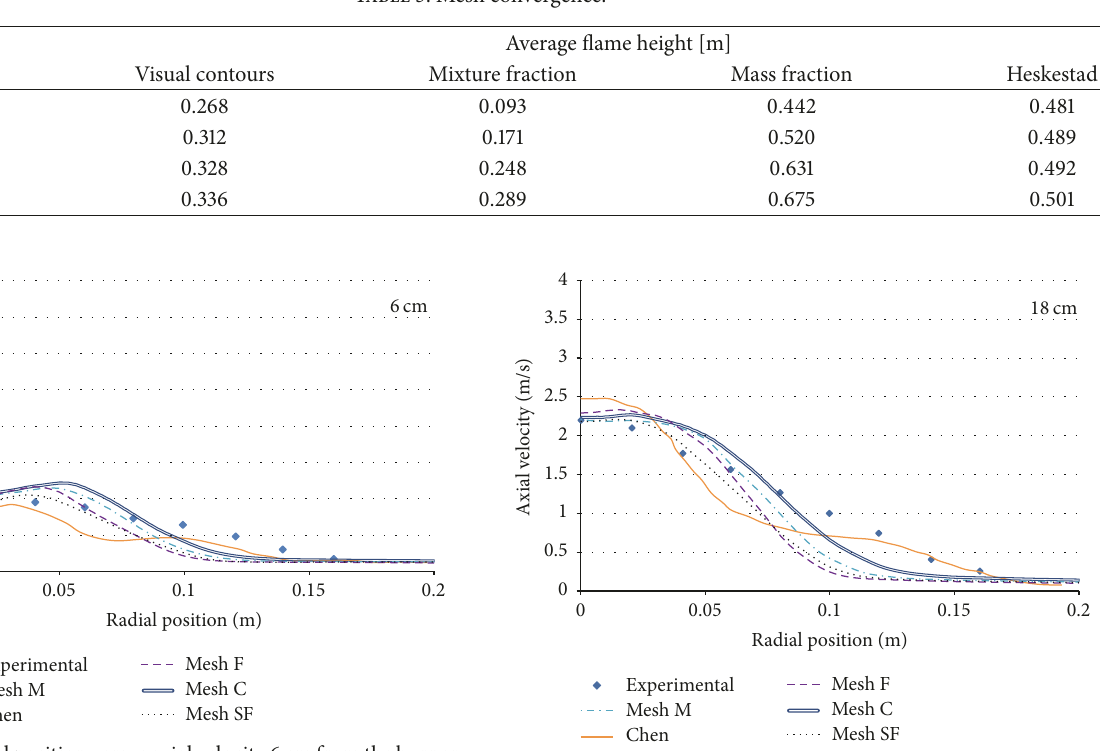
Figure11:Radial positionversusaxial velocity 6cm fromtheburner exit.